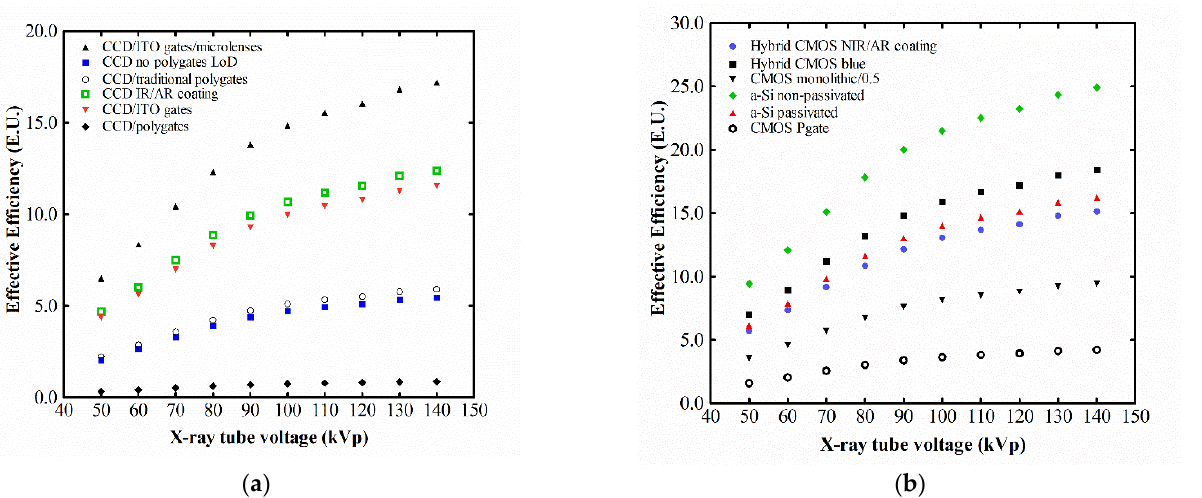
Figure 6. CeBr 3 effective efficiency with: ( a ) charge-coupled-devices; ( b ) complementary metal-oxide semiconductors.